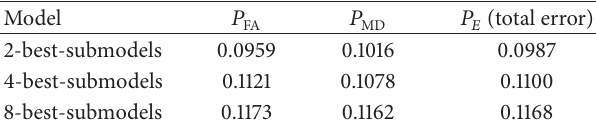
Table 6: Detection results of the merger submodels.